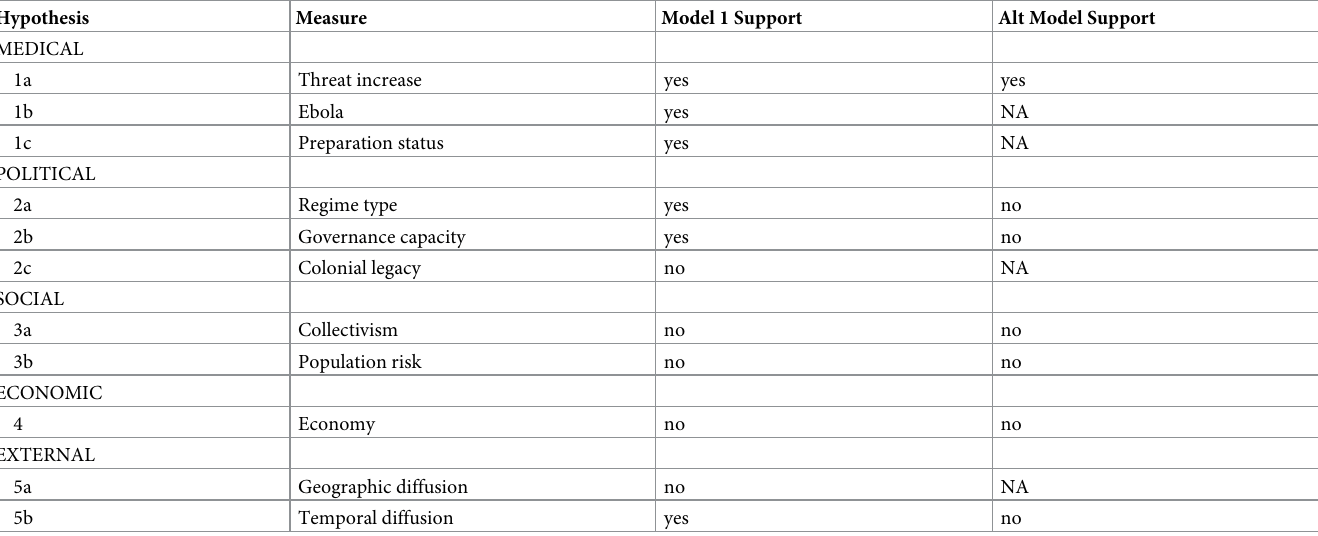
Table 6. Summary of results by